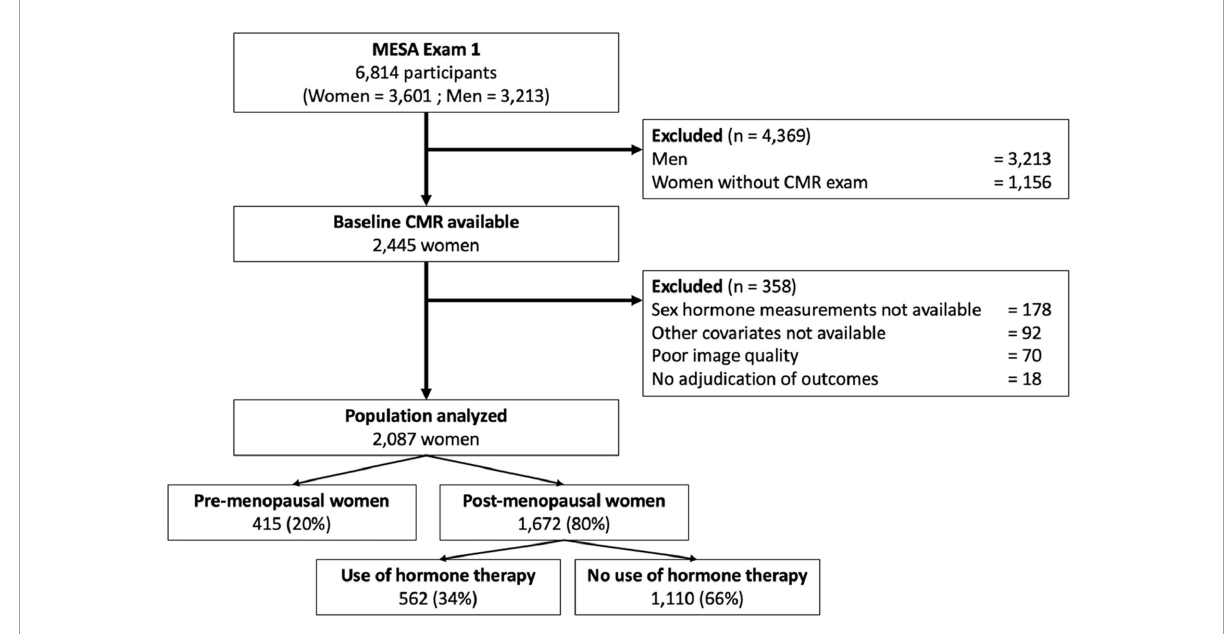
FIGURE1 Flowchart of the